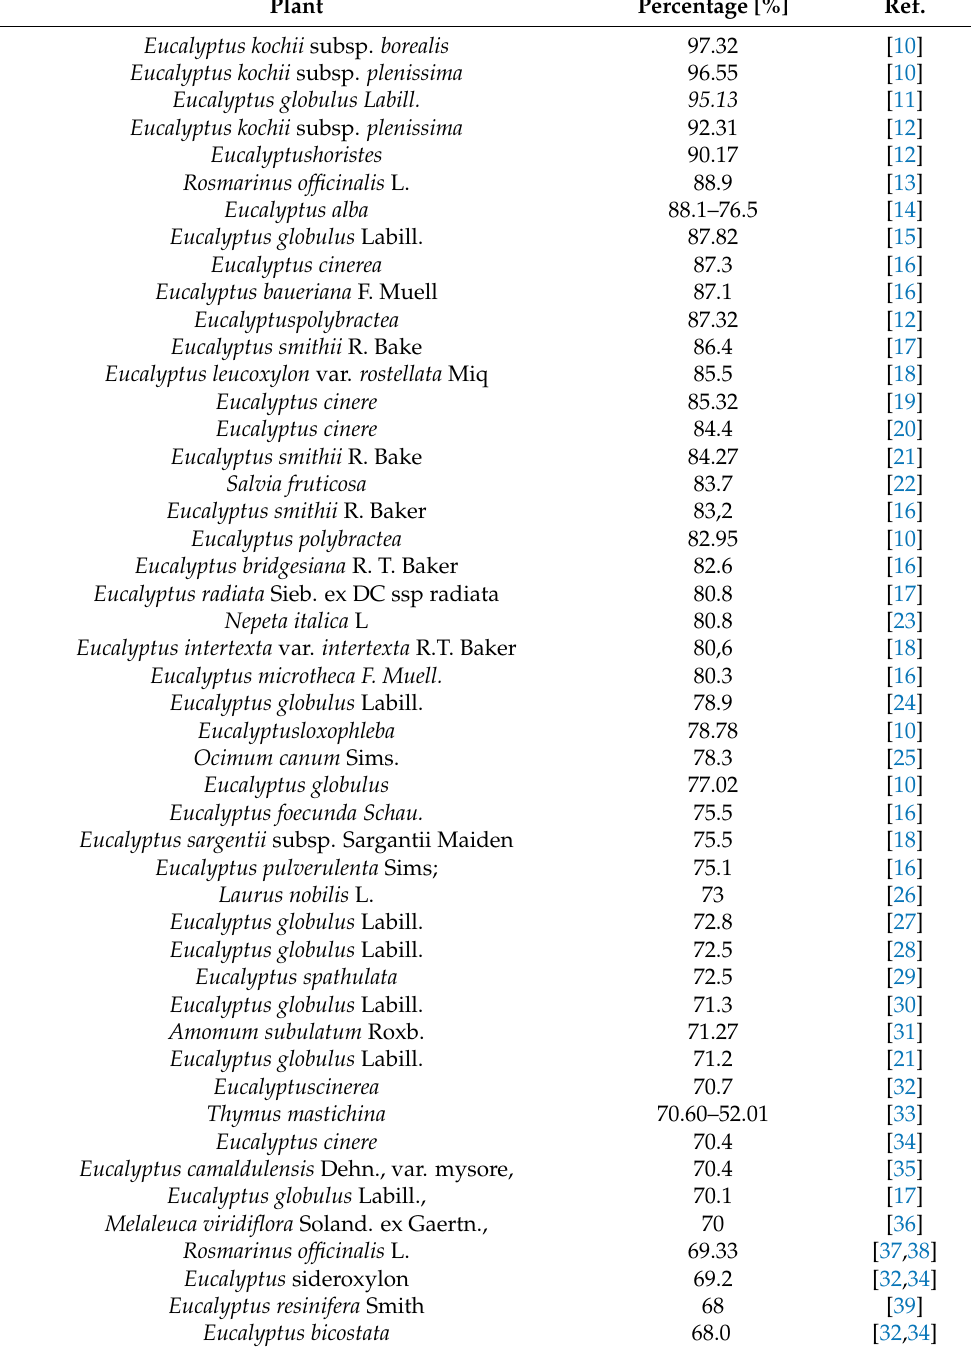
Table 1. Plant resources of